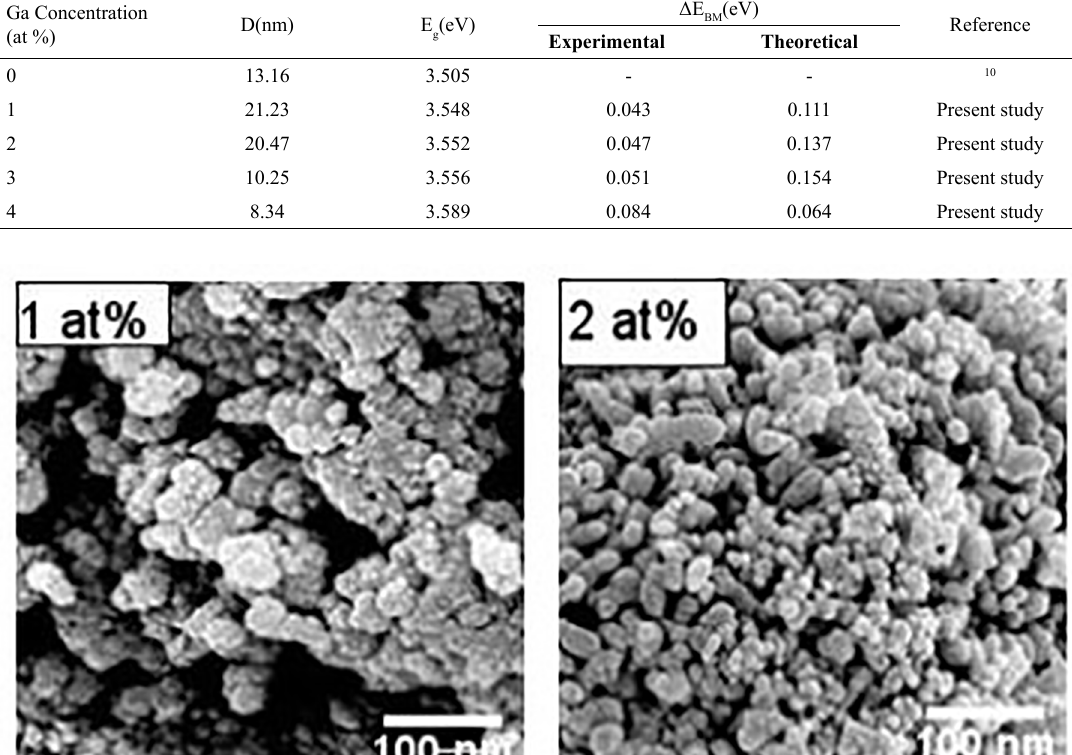
) of Zn Ca O BM 0.85 0.15